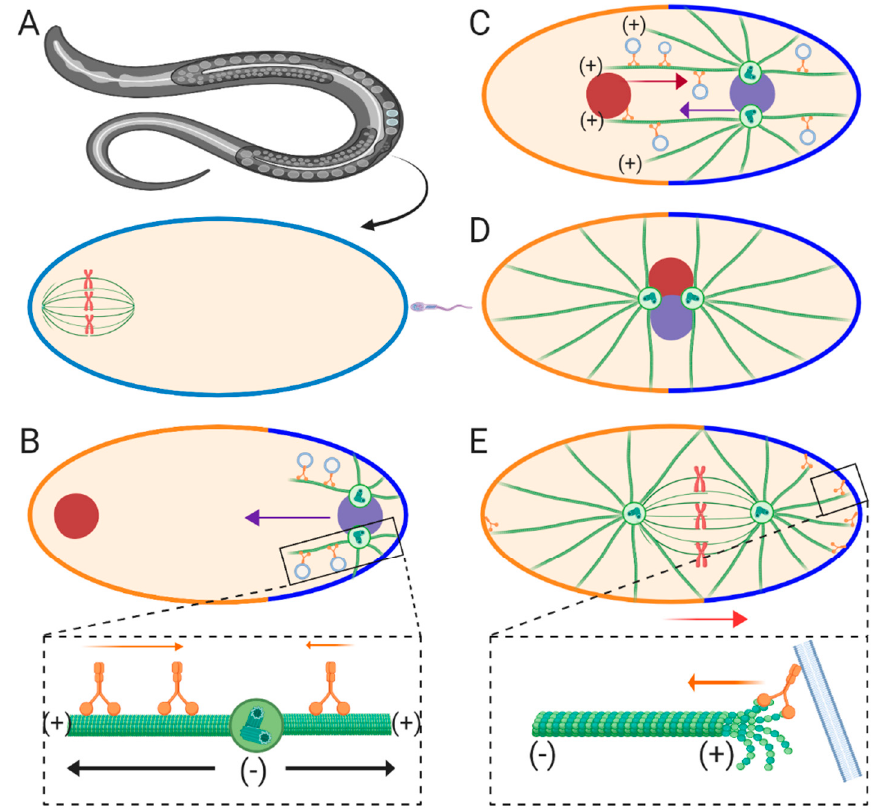
Figure 1. Fertilization and pronuclear migration in C. elegans . ( A ) The C. elegans oocyte is arrested in metaphase of meiosis I just prior to fertilization. The meiotic spindle is located on the future anterior end of the oocyte, while the sperm/male pronucleus enters on the future posterior end. ( B ) Early centration phase. Fertilization prompts the completion of meiosis and formation of the female pronucleus (red circle). After sperm entry and maturation of the paternally derived centrioles, two sperm asters form oriented on opposite sides of the male pronucleus (purple circle), perpendicular to the anterior-posterior axis. These asters help define the posterior half (bright blue plasma membrane). The asters migrate toward the egg center due to cytoplasmic dynein-dependent pulling forces that scale with MT length (inset). Force (black arrows) is generated in the opposite direction of movement (orange arrows). Therefore, more force is generated on the longer front MTs relative to the short rear/cortical facing MTs. ( C ) Late centration phase. The aster pairs expand during the centration phase, enlarging the posterior half relative to the anterior half of the egg (blue and orange membrane, respectively). The female pronucleus is captured by long front astral MTs and is transported to the male pronucleus by dynein. ( D ) Maintenance phase. The combined male and female pronucleus (pronuclear complex or PNC) finish migrating to the egg center and rotate. This rotation orients